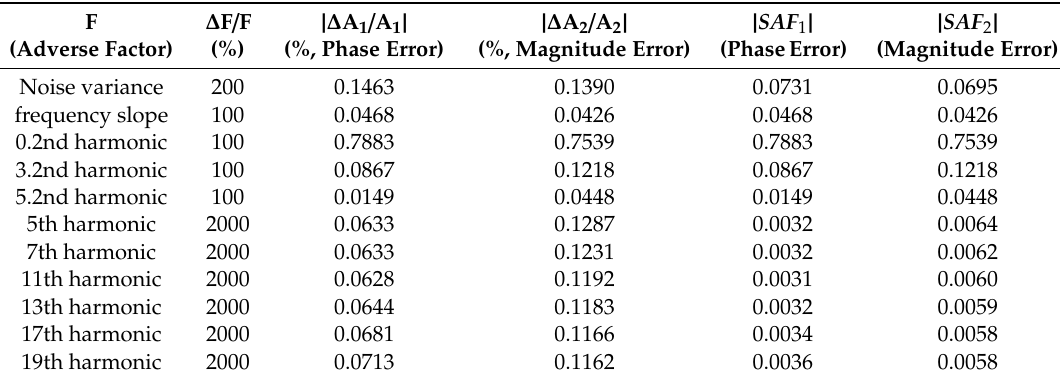
Table 3. Sensitivity analysis